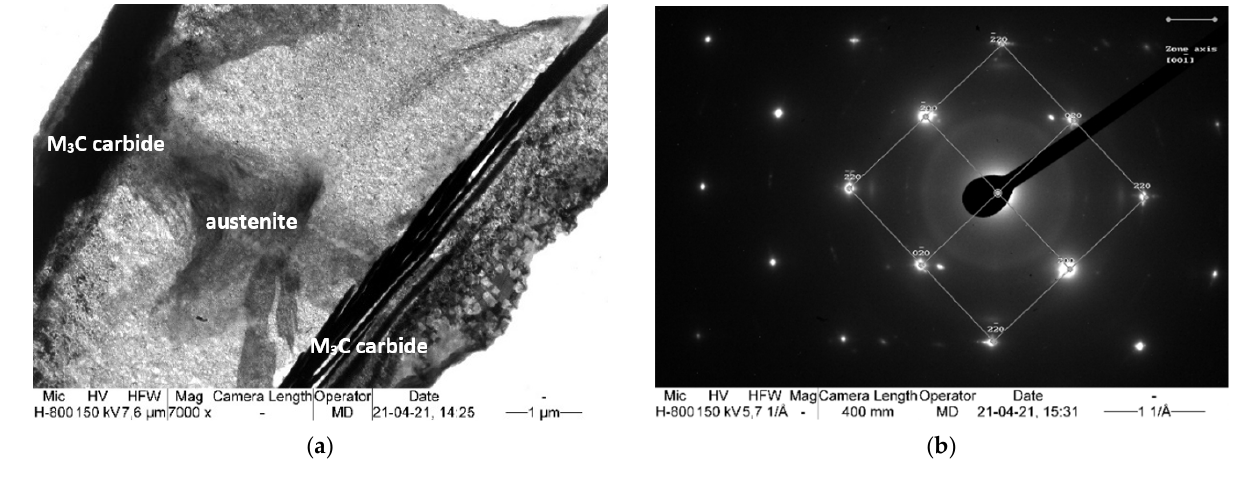
Figure 5. ( a ) Thin M 3 C carbide plates in the austenite matrix. ( b ) Diffraction pattern obtained from the grain of austenite with zone axis [ 001(cid:3364) ] showed in ( a ). TEM.